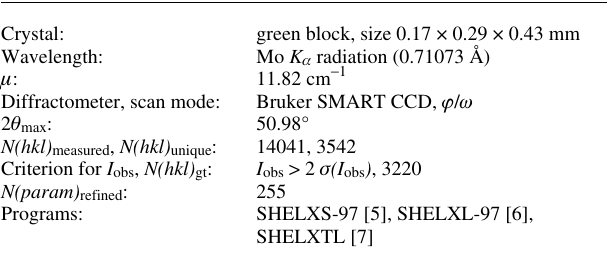
Table 1. Data collection and handling.